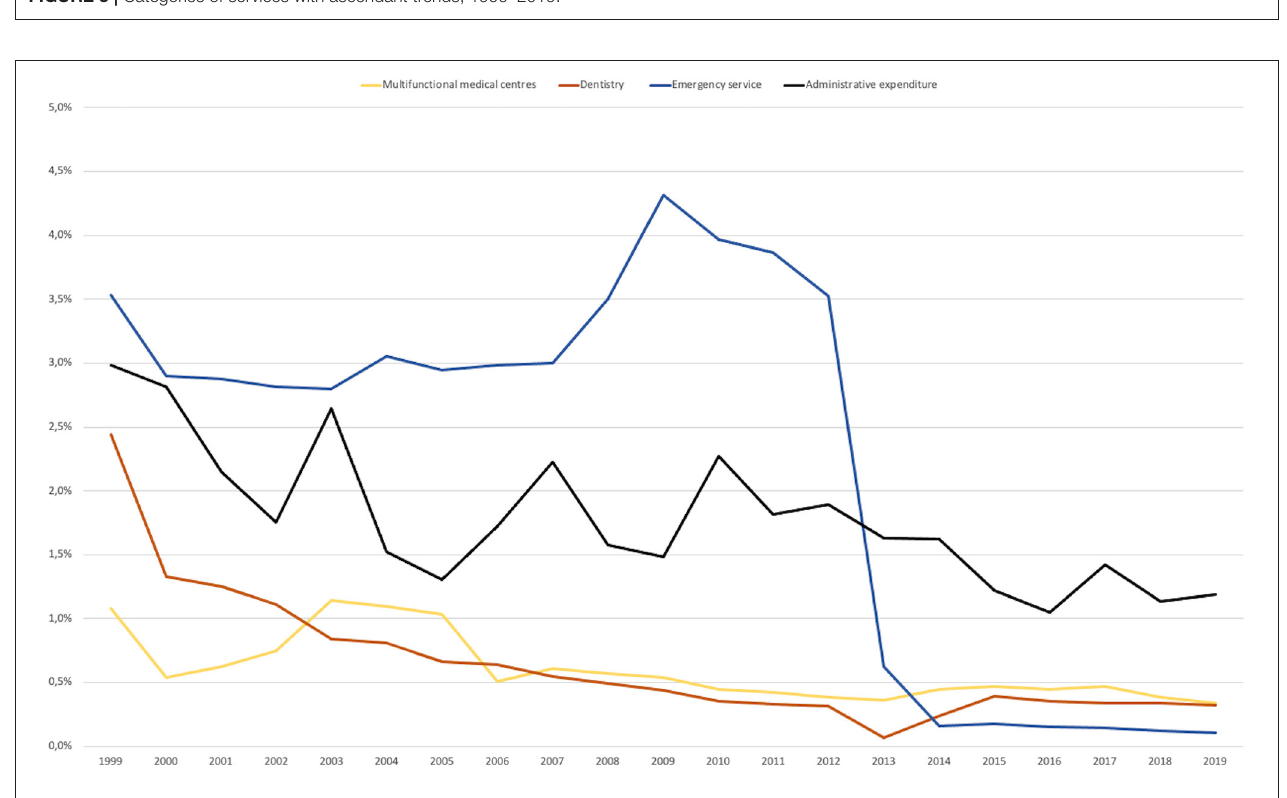
FIGURE 4 | Categories of services with descendent trends,